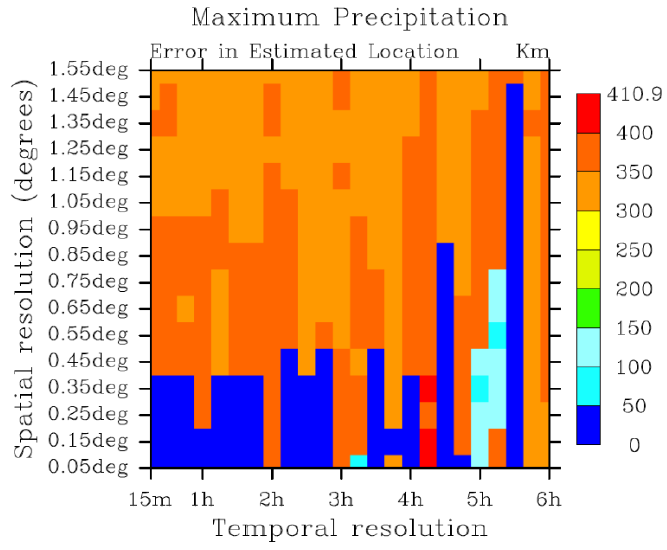
Figure 7. Errors in the estimated location of the maximum precipitation at the spatial and temporal resolutions explored in the paper.